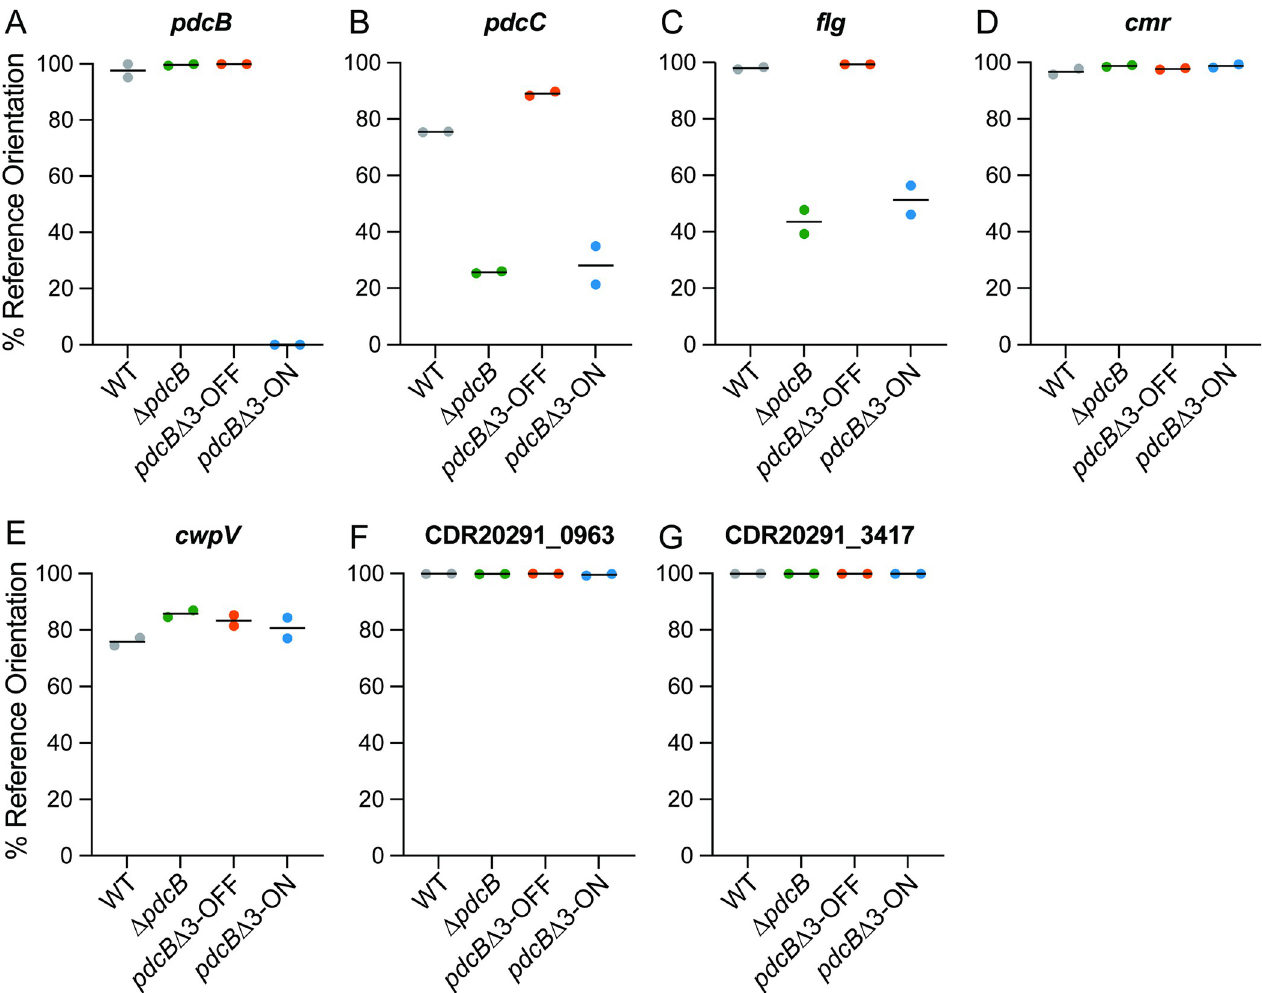
Fig 7. Orientations of the other invertible sequences do not correlate with the phenotypes of the pdcB mutants. Genomic DNA from WT, Δ pdcB , pdcB Δ 3-ON, and pdcB Δ 3-OFF grown on BHIS agar was subjected to OS-qPCR for the invertible elements pdcB (A), pdcC (B), flg (C), cmr (D), cwpV (E), CDR20291_0963 (F), and CDR20291_3417 (G). The data are presented as the percentage of the invertible element in the orientation of the reference R20291